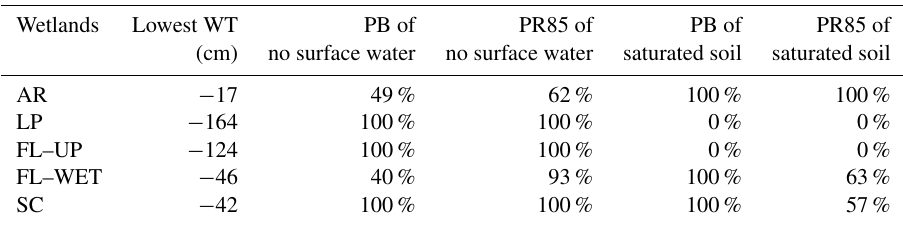
Table 5. A summary of 15-day water table fluctuations in the growing season under the future RCPs 8.5 scenario of five wetlands in the SE United States.